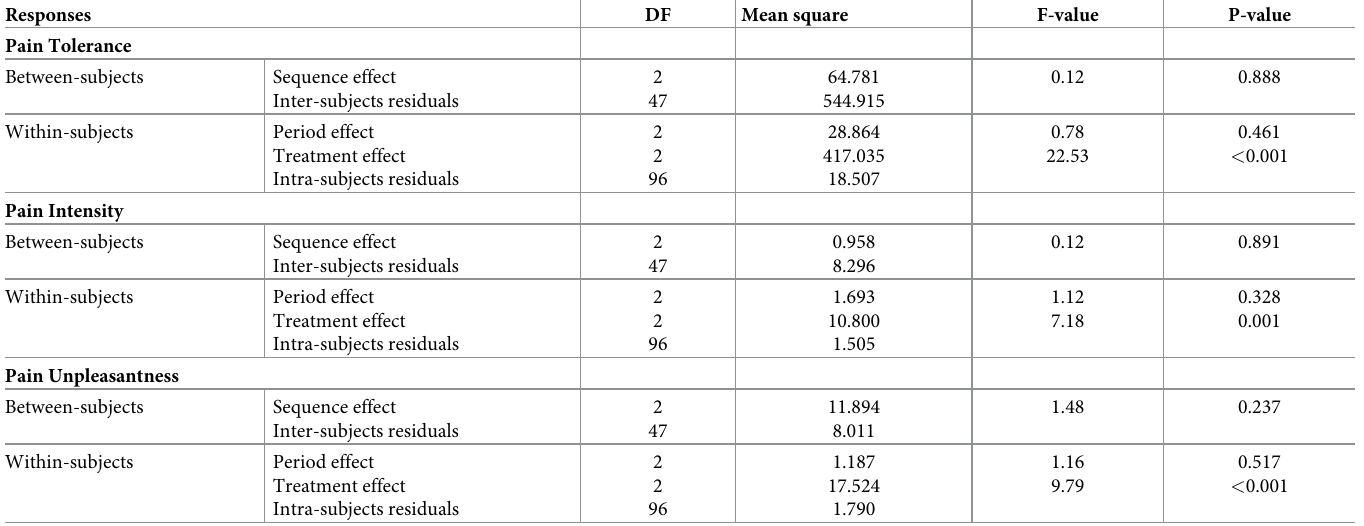
Table 2. ANOVA tables for PT, PI, and PU